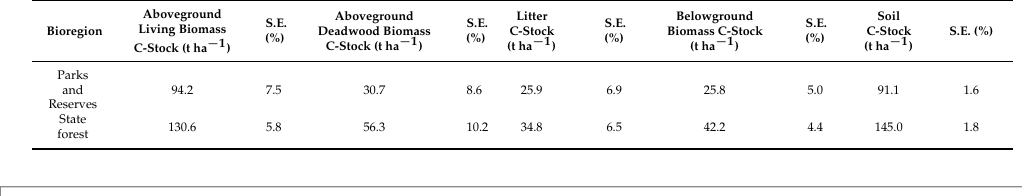
Table 2. Public land forest area within tenure categories and estimated carbon stock per hectare (with standard errors, S.E.) for different carbon pools.